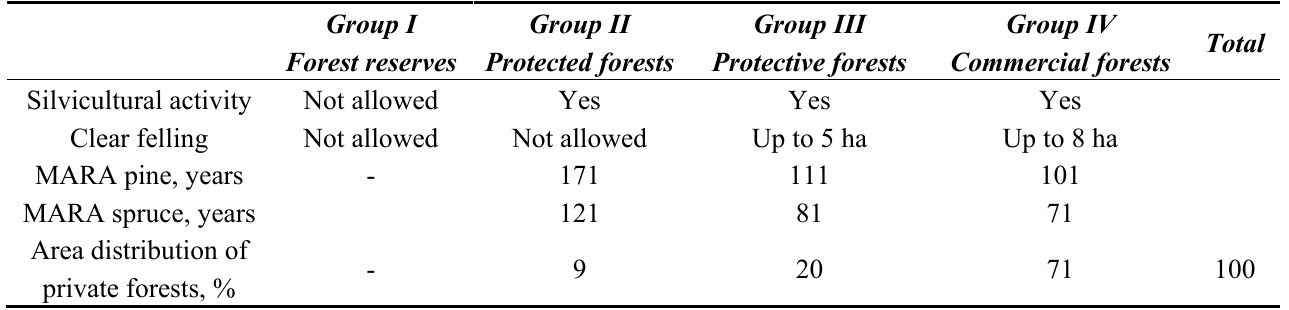
Table 3. Selected features of Lithuanian forest groups (forestland